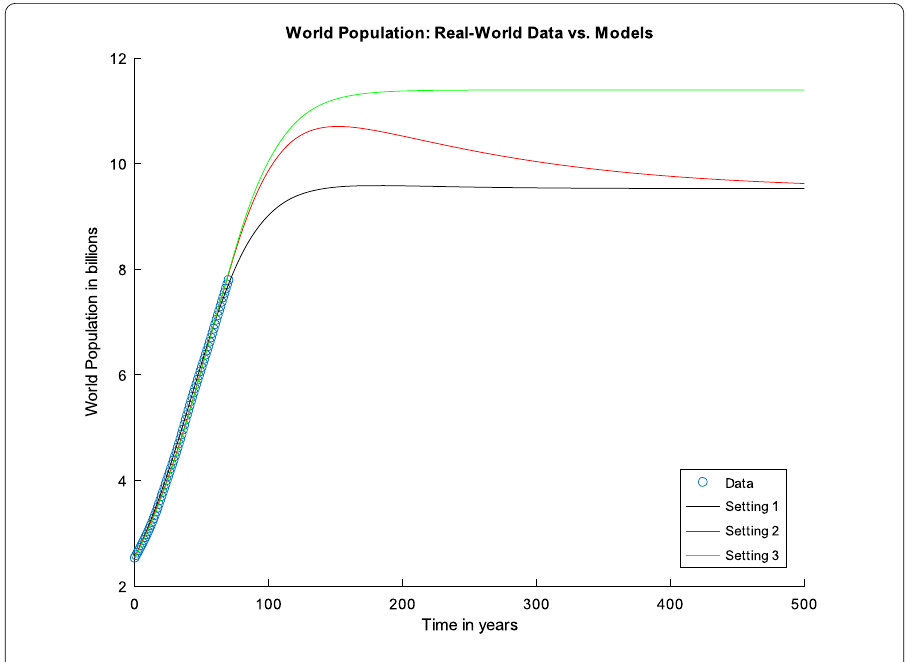
Figure 6 Results for all three settings of total world population size. Here t = 0 corresponds to the year 1950, and t = 69 corresponds to the year 2019. This is the time frame for our data points